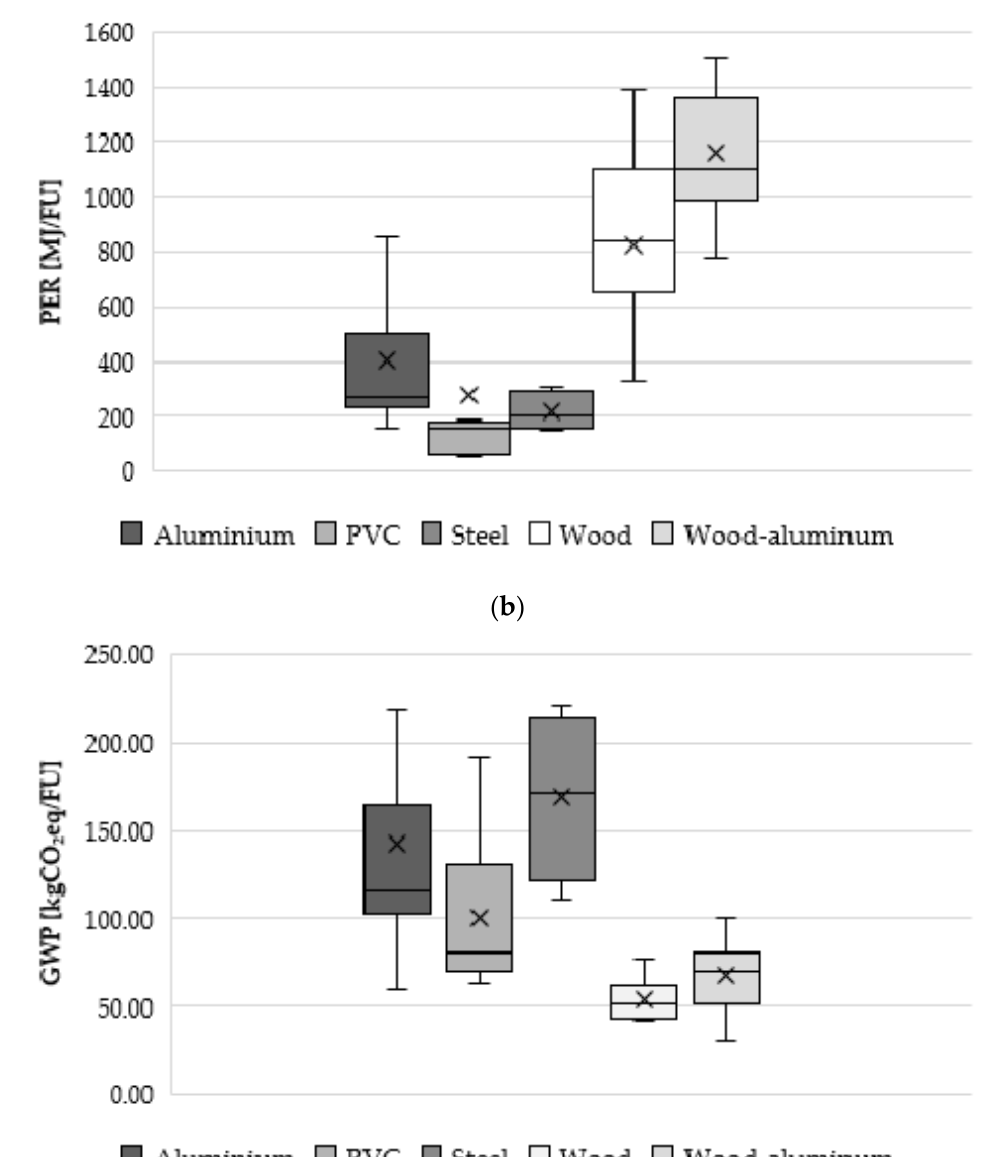
Figure 4. Embodied impacts of triple-glazed window for different frame material: ( a ) PERN, ( b ) PER, ( c ) GWP. Instead, Tables 6 and 7 show the minimum, maximum and average values for PENR, PER and GWP of the different types of windows. Table 6. Minimum, maximum and average values for PENR, PER and GWP of the double-glazed windows analyzed according to the different frame materials.